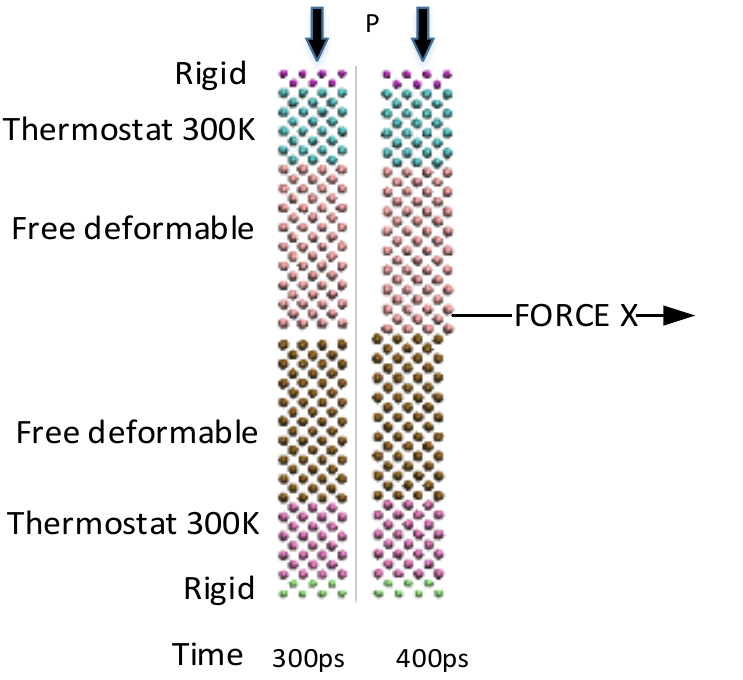
Figure 5. The typical system slices (70 Å < x < 80 Å) at the moment of 300 and 400 ps. The unusual force Fx is due to the change of the upper and lower walls from initial mismatch pattern to match pattern.